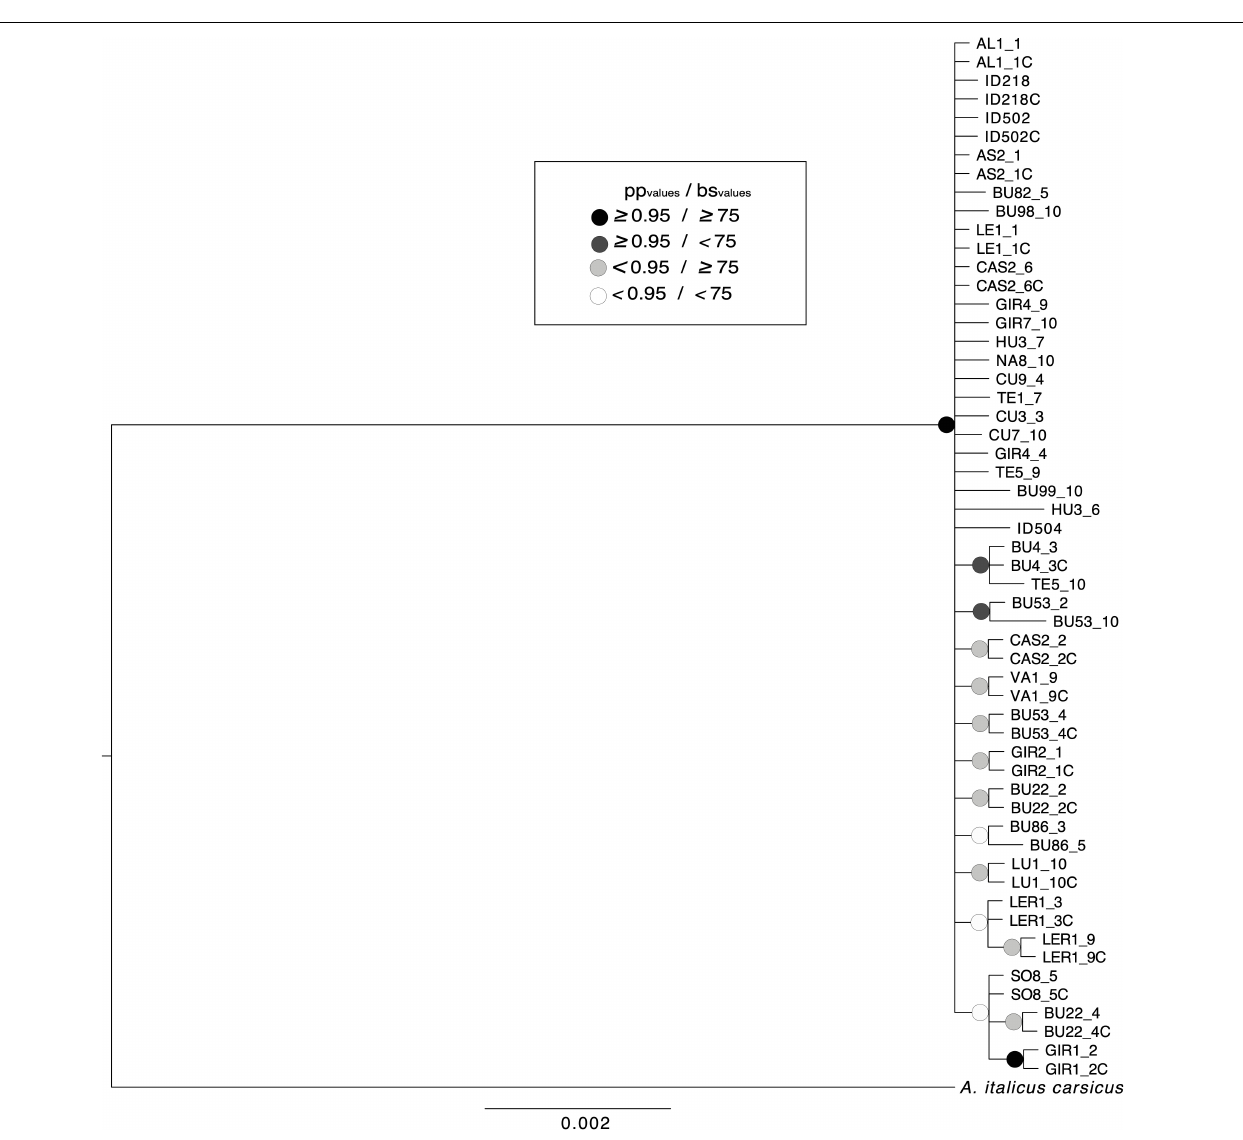
FIGURE 2 | Bayesian inference analyses based on concatenated mitochondrial 16S rRNA and COI genes sequences from Data Set 2. The posterior probability values (pp values) are from Bayesian inference analysis and the bootstrap support values (bs values) from Maximum Likelihood. Nodes with black circles have pp values higher than 0.95 and bs higher than 75, nodes with dark gray circles have pp higher than 0.95 and bs lower than 75, nodes with light gray circles have pp lower than 0.95 and bs higher than 75, and nodes with white circles have pp lower than 0.95 and bs lower than 75. Scales bar for phylogenetic analysis indicates substitutions per